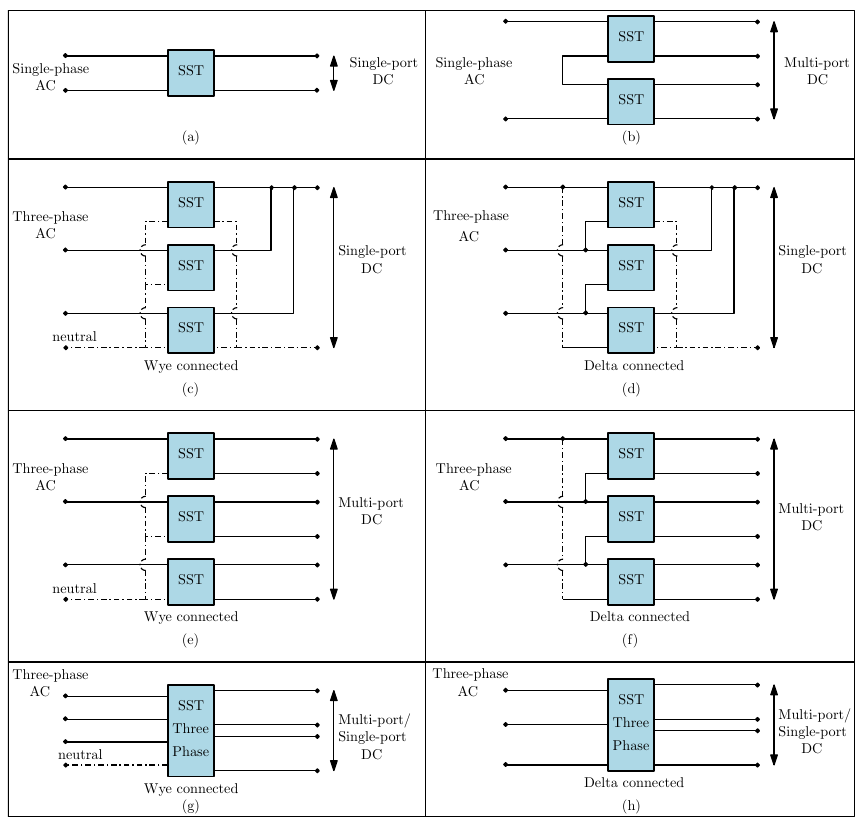
Figure 11. Topology configuration based on input type and output ports: ( a ) SPSP; ( b ) SPMP; ( c ) TPSP-SPC wye connected; ( d ) TPSP-SPC delta connected; ( e ) TPMP-SPC wye connected; ( f ) TPMP- SPC delta connected; ( g ) TPSP-TPC/TPMP-TPC wye connected; ( h ) TPSP-TPC/TPMP-TPC delta